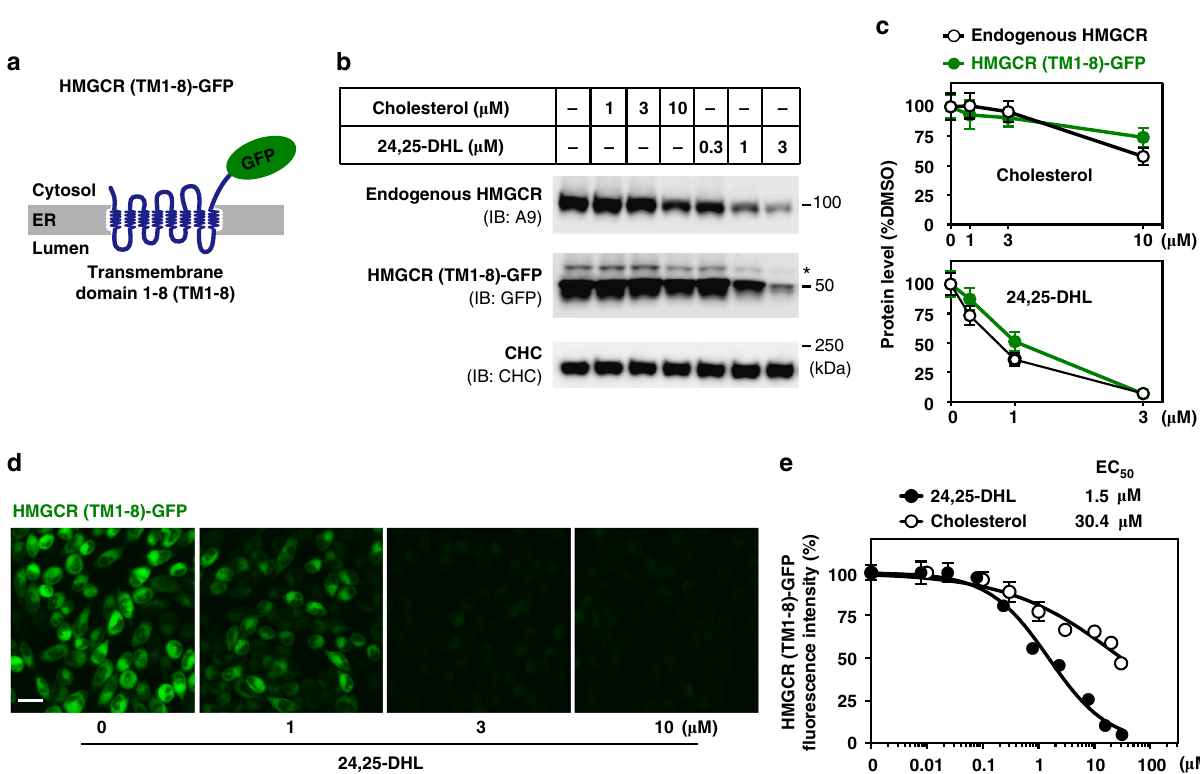
Fig. 2 A reporting system that measures HMGCR degradation. a Schematic of the HMGCR (TM1-8)-GFP fusion protein. TM, transmembrane. b , c CHO-7 cells stably expressing HMGCR (TM1-8)-GFP (CHG) were incubated with cholesterol or 24,25-DHL at indicated concentrations for 16 h and harvested for immunoblotting. b Endogenous HMGCR (IgG-A9) and overexpressed HMGCR (TM1-8)-GFP (polyclonal rabbit anti-GFP) protein were analyzed by immunoblotting. Asterisk represents a non-speci fi c band. c Quanti fi cation of endogenous and overexpressed HMGCR protein levels in response to cholesterol or 24,25-DHL shown in b . The mean intensity of HMGCR protein bands in DMSO-treated cells was de fi ned as 100. d , e CHG cells were incubated with varying concentrations of 24,25-DHL for 16 h. Cells were then fi xed for immuno fl uorescence analysis. d Representative images showing a dose-dependent decrease of GFP signals following 24,25-DHL treatment. Scale bar, 20 μ m. e Dose – response curves of HMGCR (TM1-8)-GFP fl uorescent intensity to varying concentrations of cholesterol or 24,25-DHL. The GFP intensity of DMSO-treated cells was de fi ned as 100. The mean EC 50 values of cholesterol and 24,25-DH were 30.4 μ M and 1.5 μ M, respectively. Data are from three independent experiments and presented as mean ± SD. Source data are provided as a Source Data File. Uncropped immunoblots are shown in Supplementary Fig.